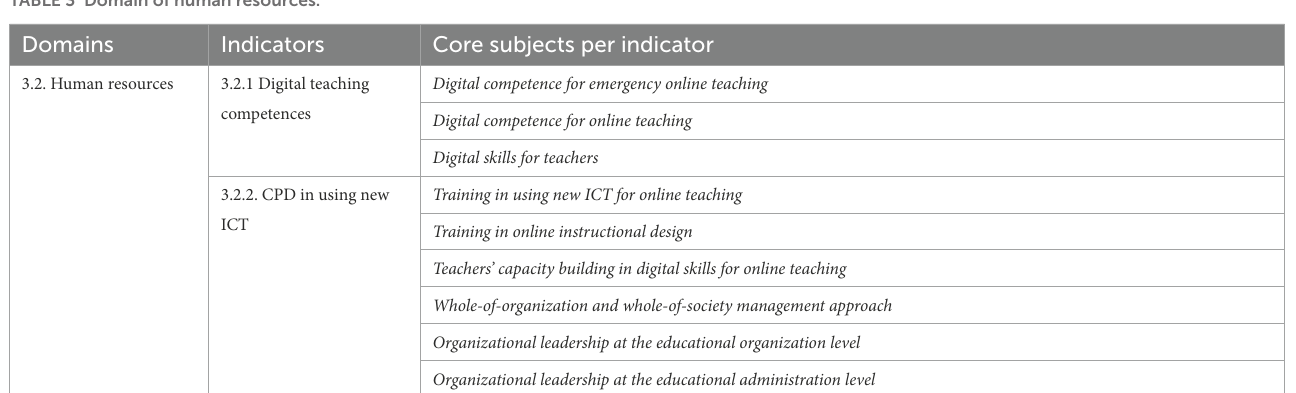
TABLE 3 Domain of human